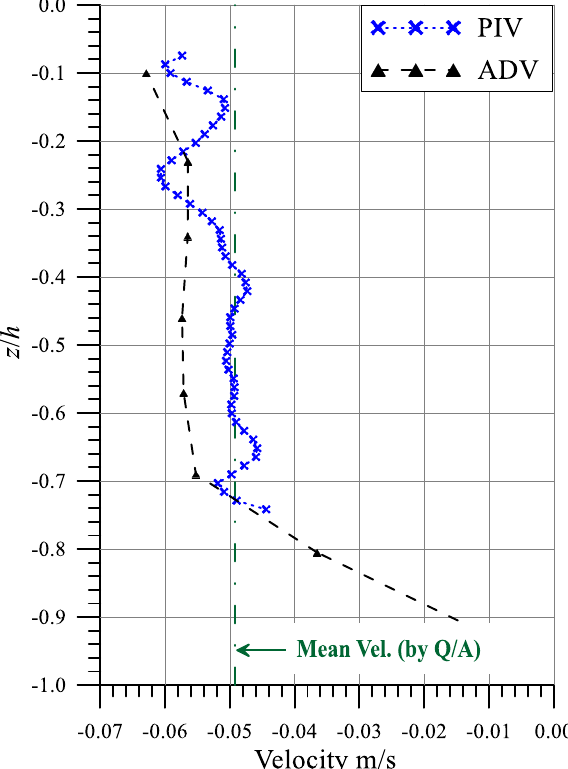
Figure 6. Comparison of the vertical velocity distribution derived by the acoustic Doppler velocimetry (ADV) and the particle image velocimetry (PIV) analyses.